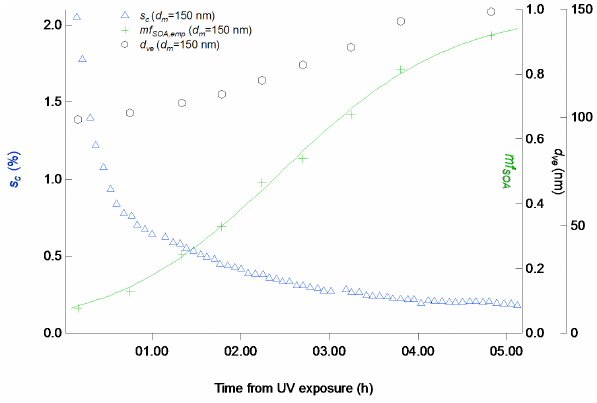
Figure 6. Changes in s c (blue), mf SOA (green markers, empirical; green line, fit) and d ve (black) over time for diesel exhaust particles, during experiment DEP2. No activation of particles was seen before the onset of